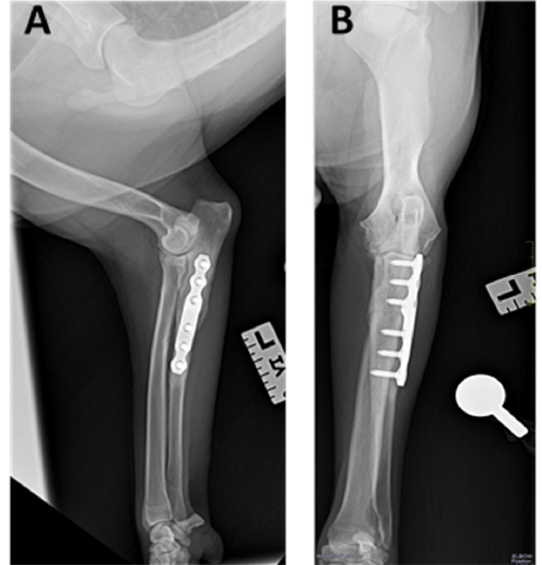
Figure 5. ( A ) Lateral and ( B ) cranio-caudal projection of the left elbow at 4 months after surgery. Radiographic evidence of union and bone remodeling between proximal and distal segments (dog 16, Table 1).